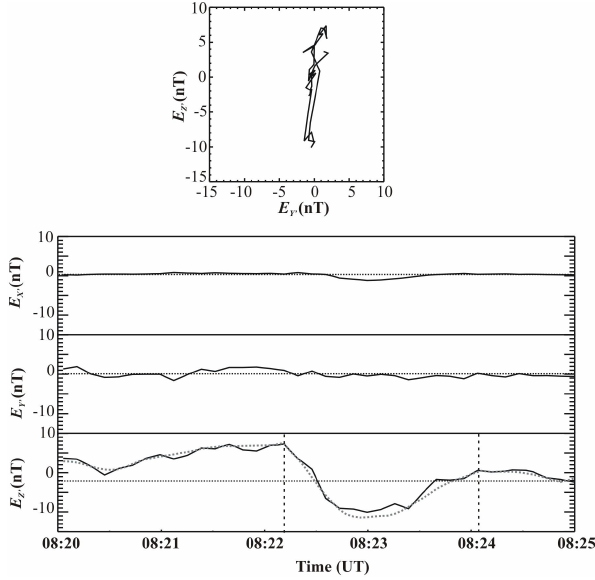
Fig. 4. Hodogram of the magnetic field (Cluster-1 data) in a plane perpendicular to the mean magnetic field direction, BX 0 , and three components of B in a new coordinate system X 0 Y 0 Z 0 . Grey dot- ted line displays BY 0 profile smoothed by the sliding average tech- nique. Vertical dashed lines mark a period of the magnetic pertur- bation.